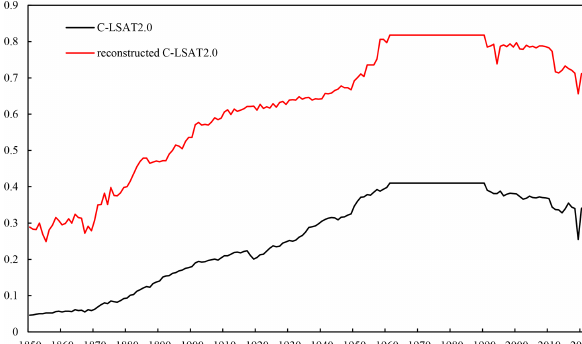
Figure 3. Coverage comparison of the terrestrial component before and after